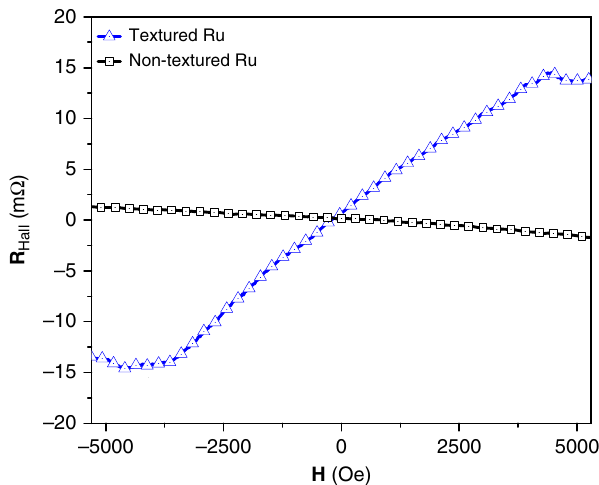
Fig. 5 Hall resistance con fi rmation of ferromagnetism. Hall resistance ( R Hall ) vs. H (applied perpendicular to surface) for textured (blue) and non-textured (black) Mo/Ru fi lms. The substrate/Mo/Ru sample, which has no crystallographic texture, shows only the ordinary Hall effect, but the Ru sample with BCT texture shows the anomalous Hall effect in addition to the ordinary Hall effect. Given that the Ru samples do not have a perpendicular easy axis, the resistance will change once the fi eld is strong enough to saturate the demagnetization fi eld of 4 π M s , corresponding to a M s of ~318 emucm − 3 . The saturated regions are designated by black